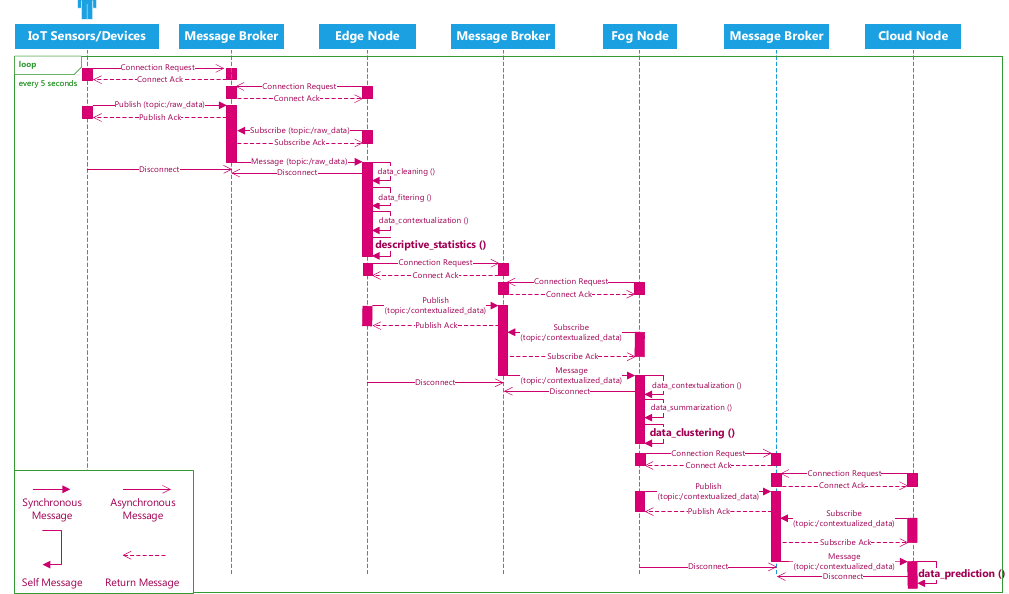
Figure 7. Sequence diagram for pushing the IoT data stream to the edge, fog, and cloud using Advanced Message Queuing Protocol (AMQP)